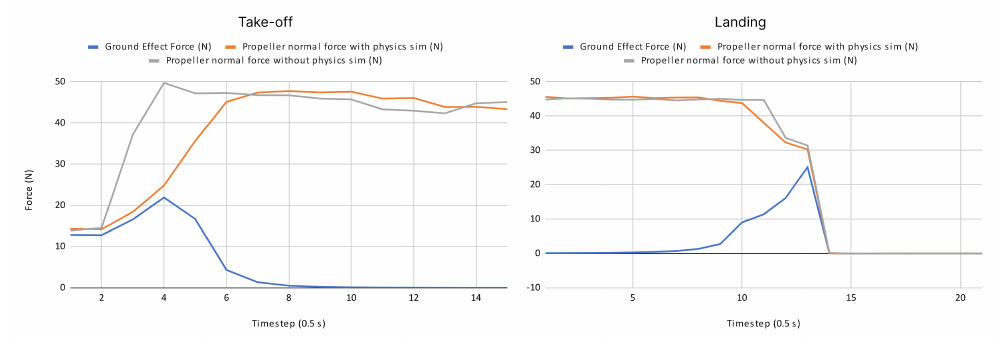
off and landing normal forces comparison with and without ground Figure 8. Take −